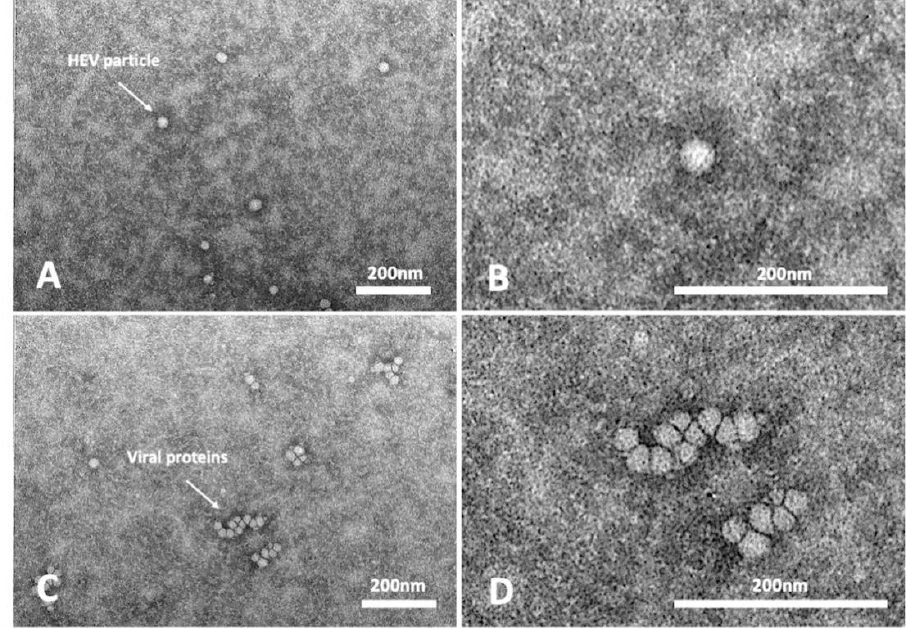
Many particles, isolates or aggregates, with structural features similar to virions but with no correct icosahedral symmetry and dimensions were also detected (Figure 2). These structures could result from improper assembly of viral proteins.